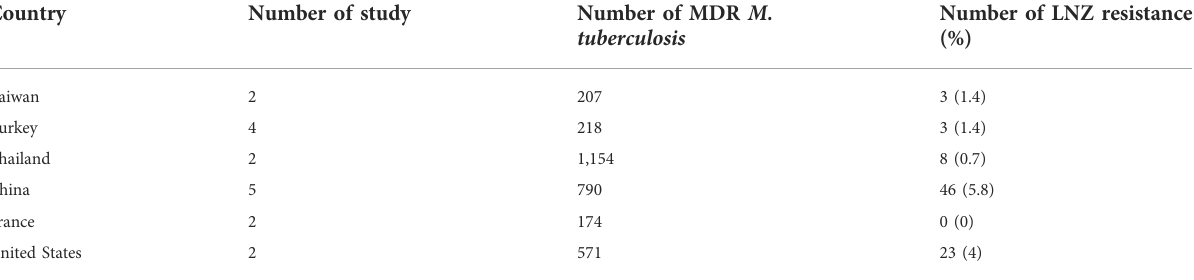
Number of LNZ resistance tuberculosis